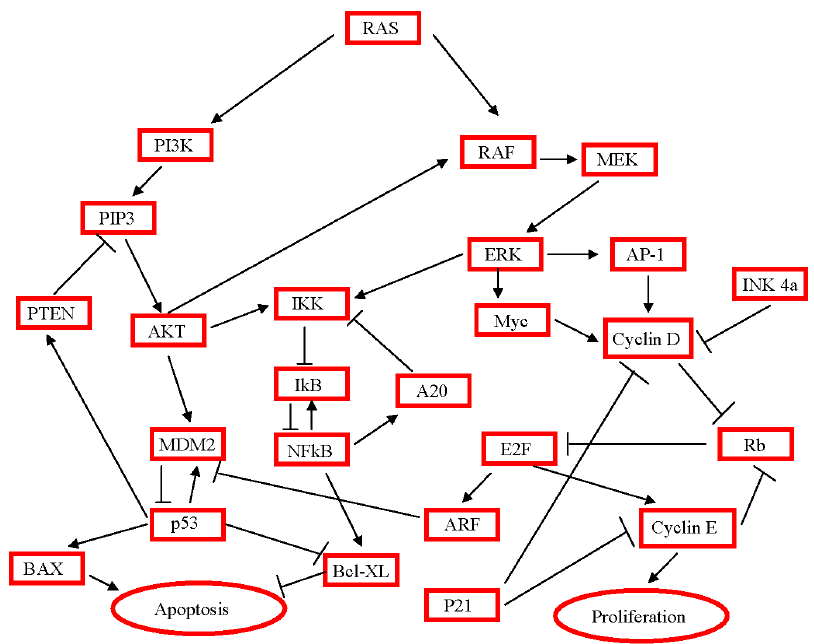
Figure 2. Interaction between pathways to regulate pancreatic